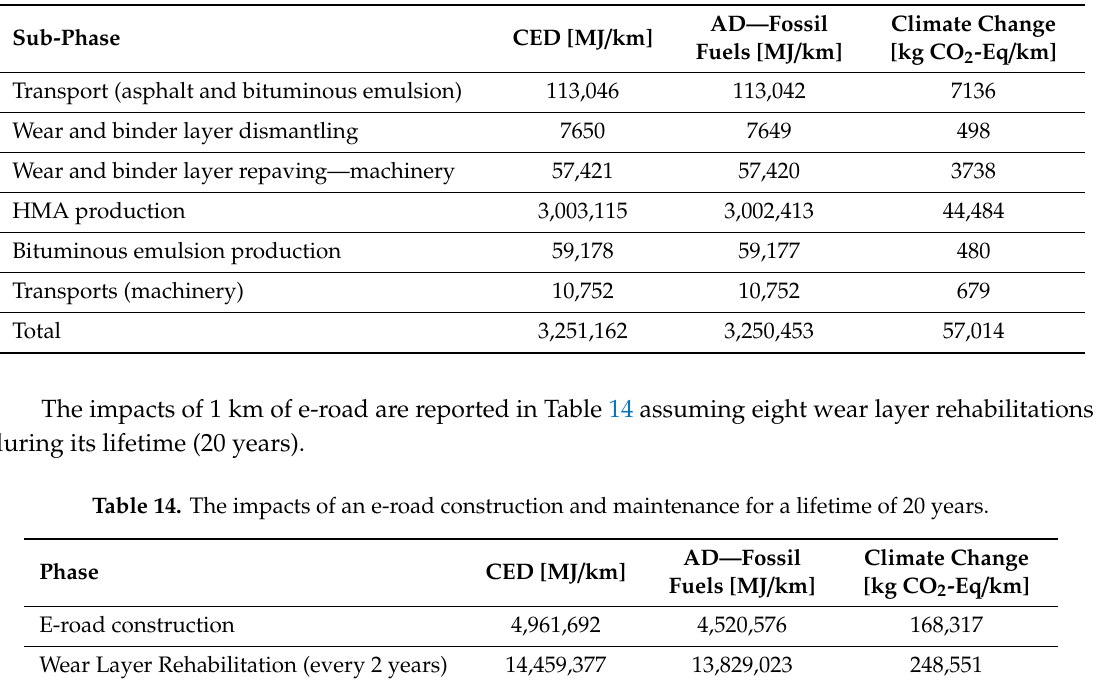
Table 13. The impacts of the wear and binder layer rehabilitation.